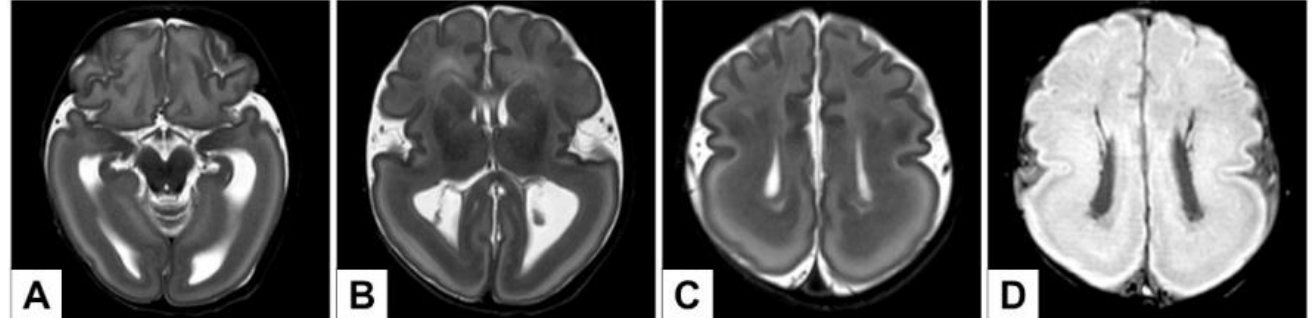
Figure 2. ( A – C ): Axial T2-weighted images. Type 1 lissencephaly (temporo–occipital–parietal prevalence) with subcortical band heterotopia (“double cortex”) ( A – C ). Rolandic regions poor differentiation with shallow Sylvian sulci and incomplete opercolarization ( C ). Bilateral partial hippocampal malrotation ( A ). Enlarged lateral ventricles in the intermediate-posterior sector ( A , B ). ( D ) SWI images (MinIP) of prominent and ectopic deep venous structures in periventricular regions.